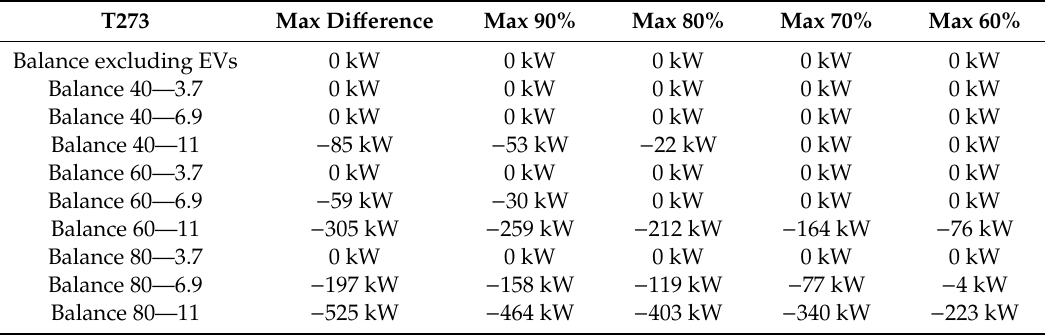
Table 17. Replacement of electric heating by district heating in the presence of flexible demand for transformer T273—Charging at